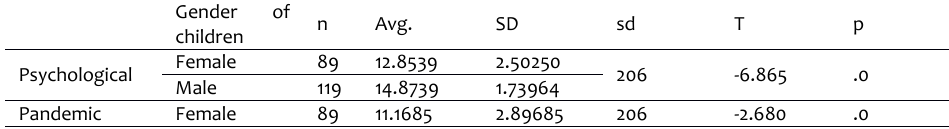
Table 5. The mean scores and t-test results of the reactions of the children to the pandemic according to the gender of the children of the parents (n=208) Gender of n children